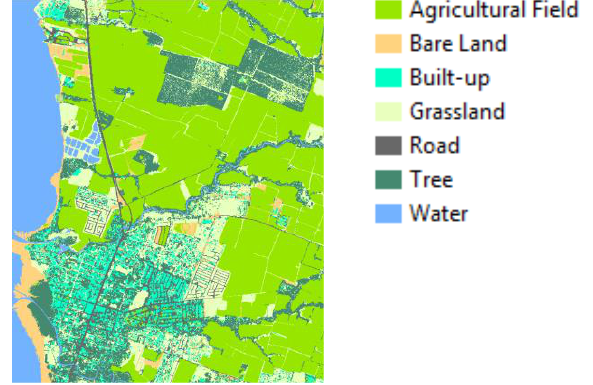
Figure 3. Land Use Land Cover Classification image with corresponding legend